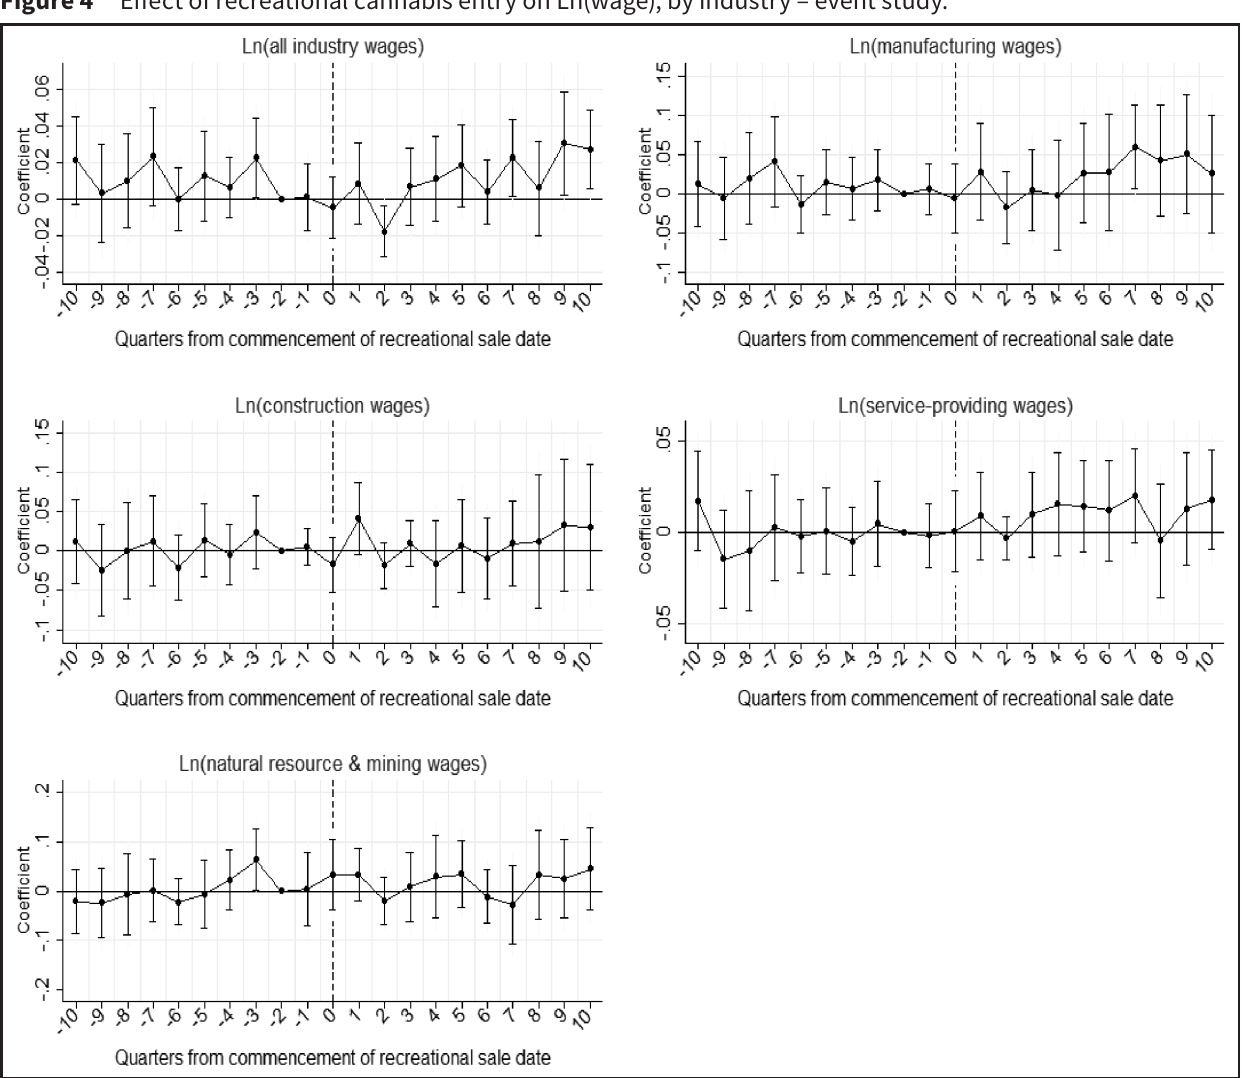
Effect of recreational cannabis entry on Ln(wage), by industry – event